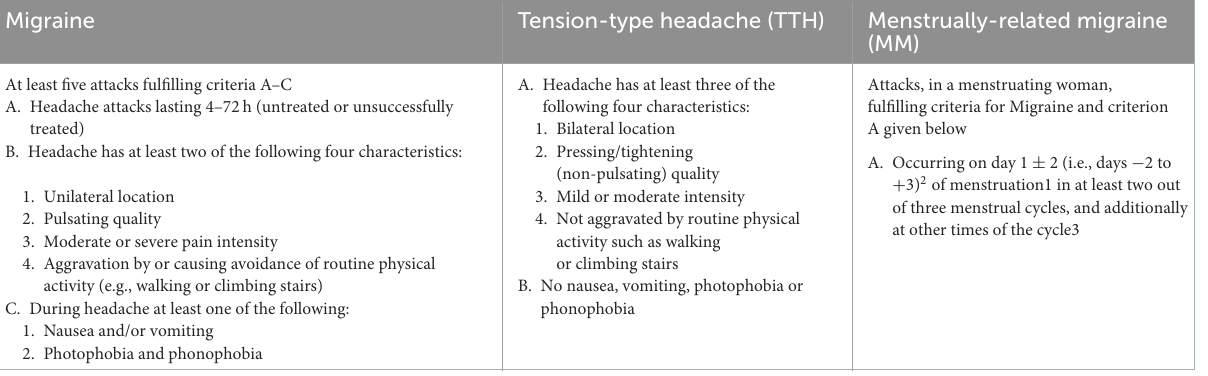
TABLE 1 Inclusion criteria for migraine and tension-type headache 10. Migraine Tension-type headache (TTH) Menstrually-related migraine